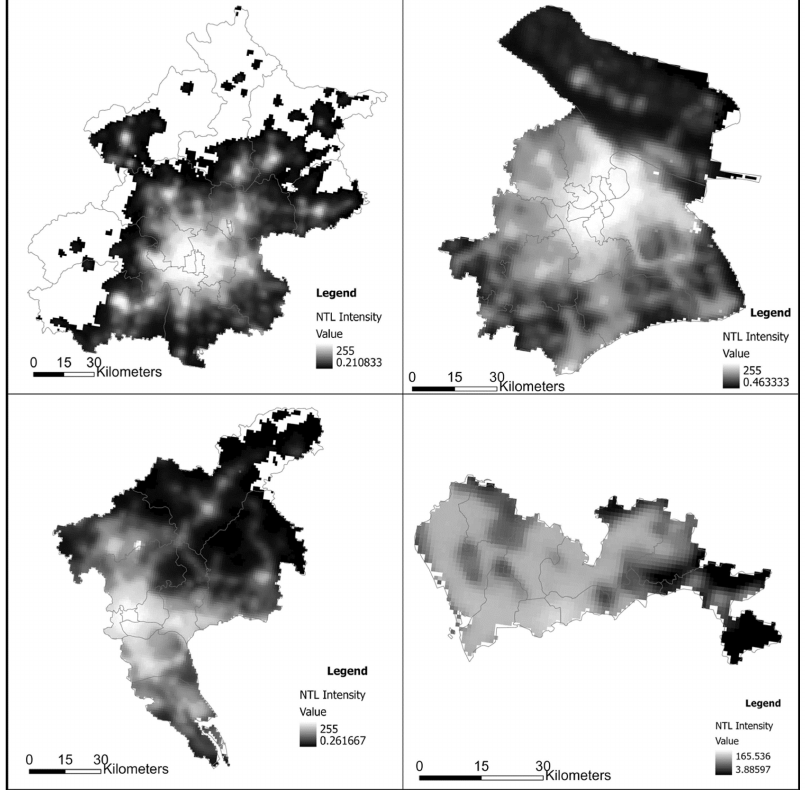
Figure 6. Nighttime image of Beijing, Shanghai, Guangzhou, and Shenzhen in 2020 (the higher the value the brighter the